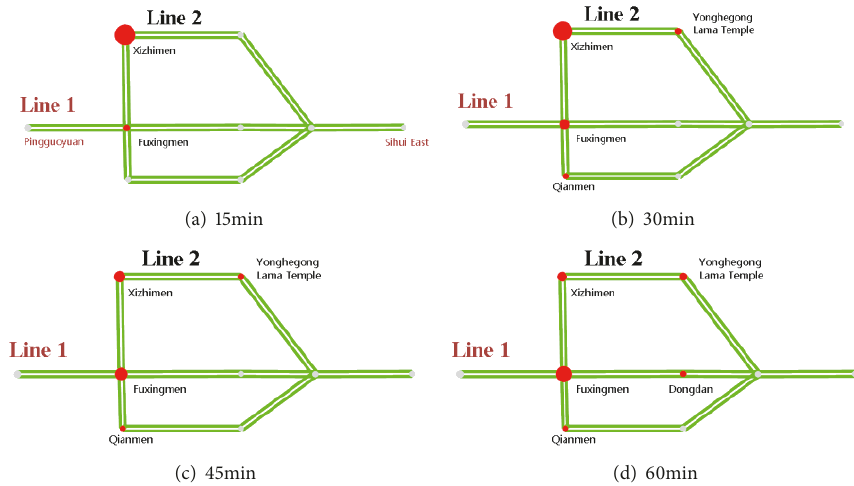
Figure 12: The replaceable departure stations passengers prefer to choose when Xizhimen is closed for different closure durations. The red circles represent the alternative origin stations, including the closed station. The size of each circle represents the number of passengers who choose that station, and a larger radius indicates relatively more passengers. (a) shows the duration of 15 minutes; (b) shows the duration of 30 minutes; (c) shows the duration of 45 minutes; (d) shows the duration of 60